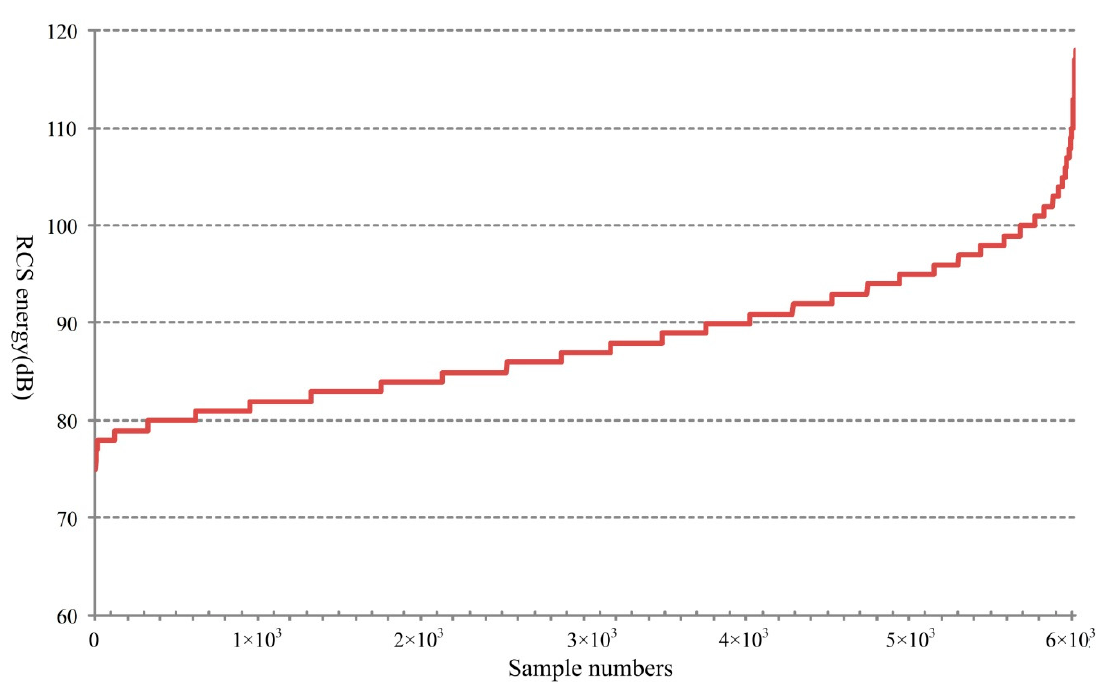
Figure 9. RCS energy order.